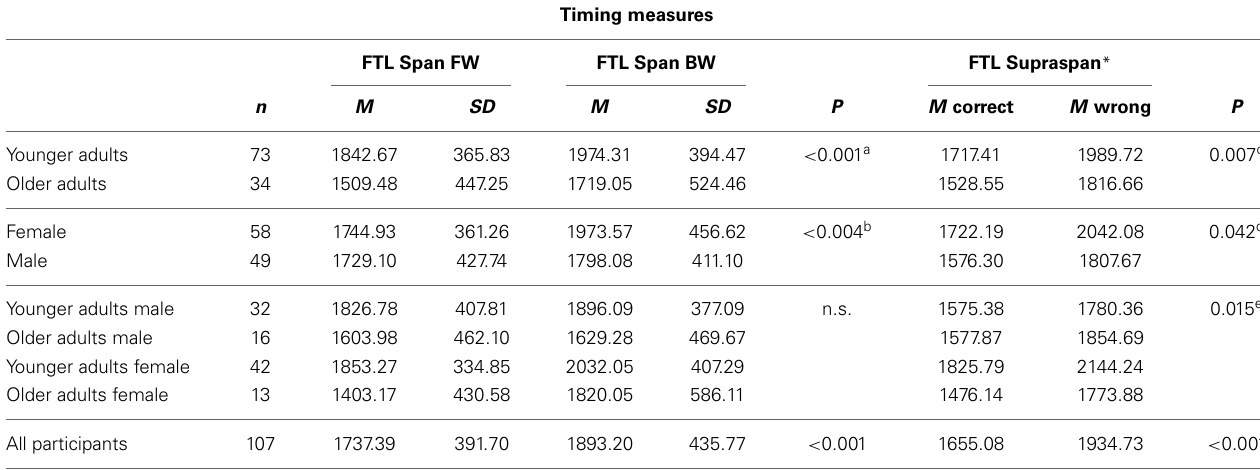
Table 2 | First Tap Latencies in all